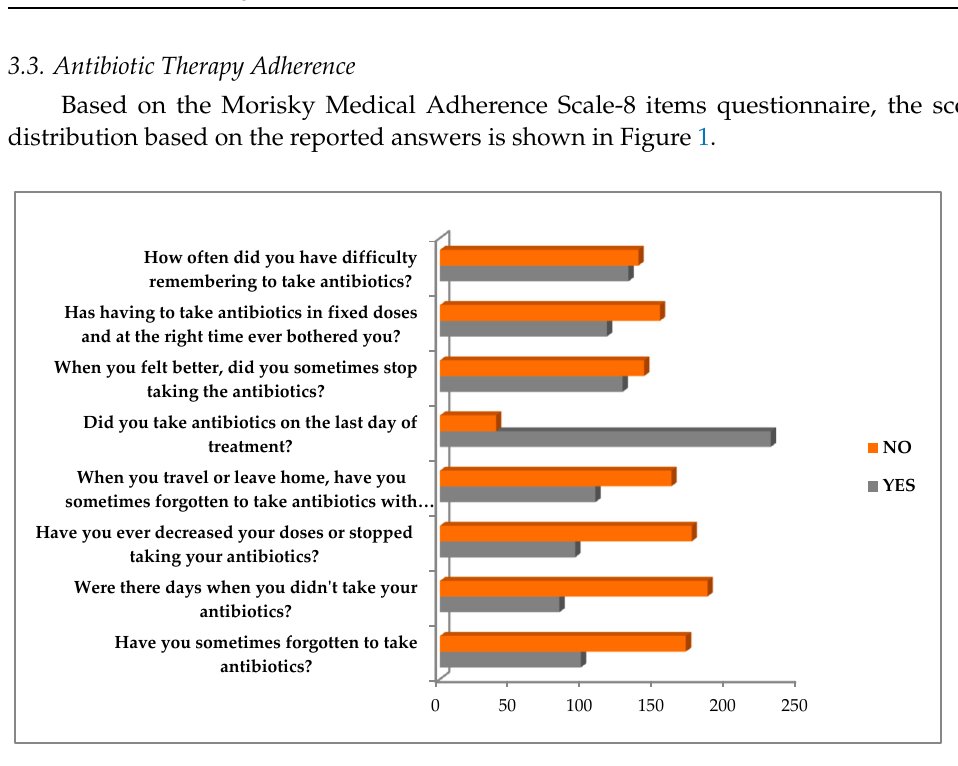
Figure 1. Distribution of the Morisky scale score based on the questions and answers. The overall level of adherence resulted as low in 270 (51.82%) subjects, medium in 153 (29.37%), and high in 98 (18.81%), respectively (Figure 2). 0